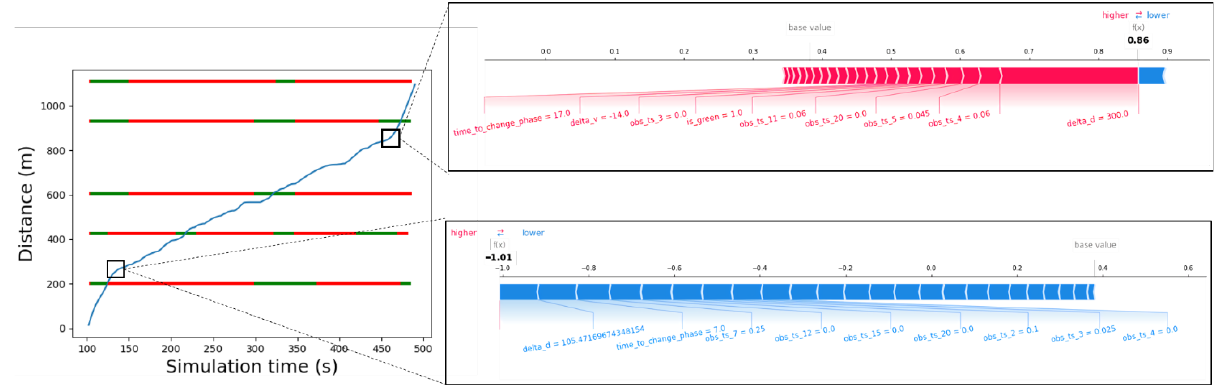
Figure 11. Sample trajectory 2 and its SHAP representation.